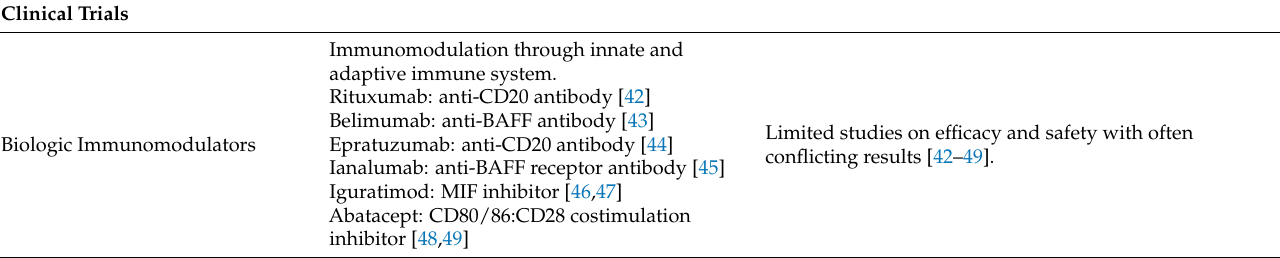
Table 2. Summary of emerging treatment options for